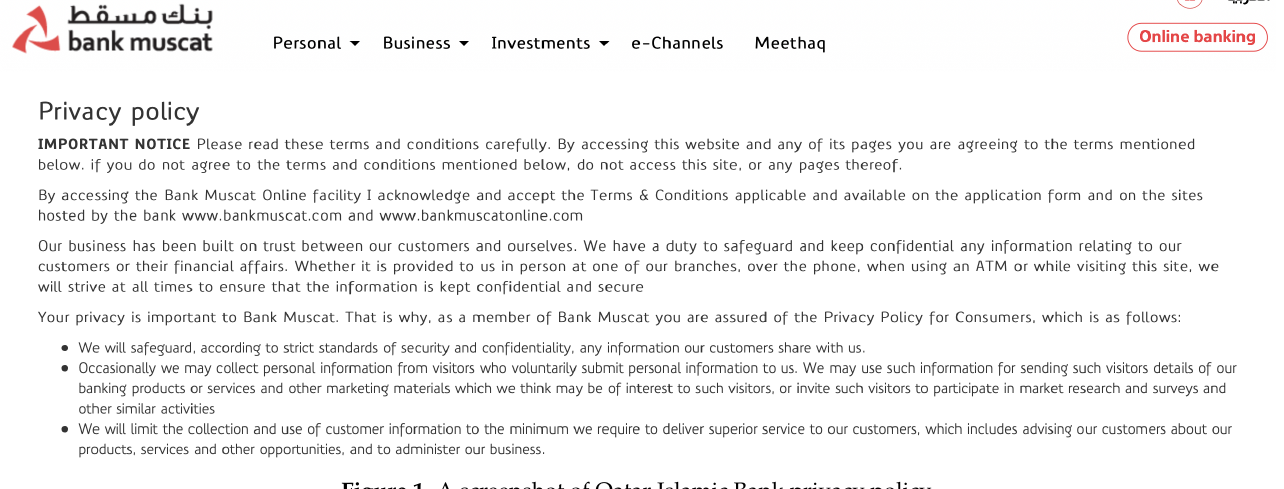
Figure 1. A screenshot of Qatar Islamic Bank privacy